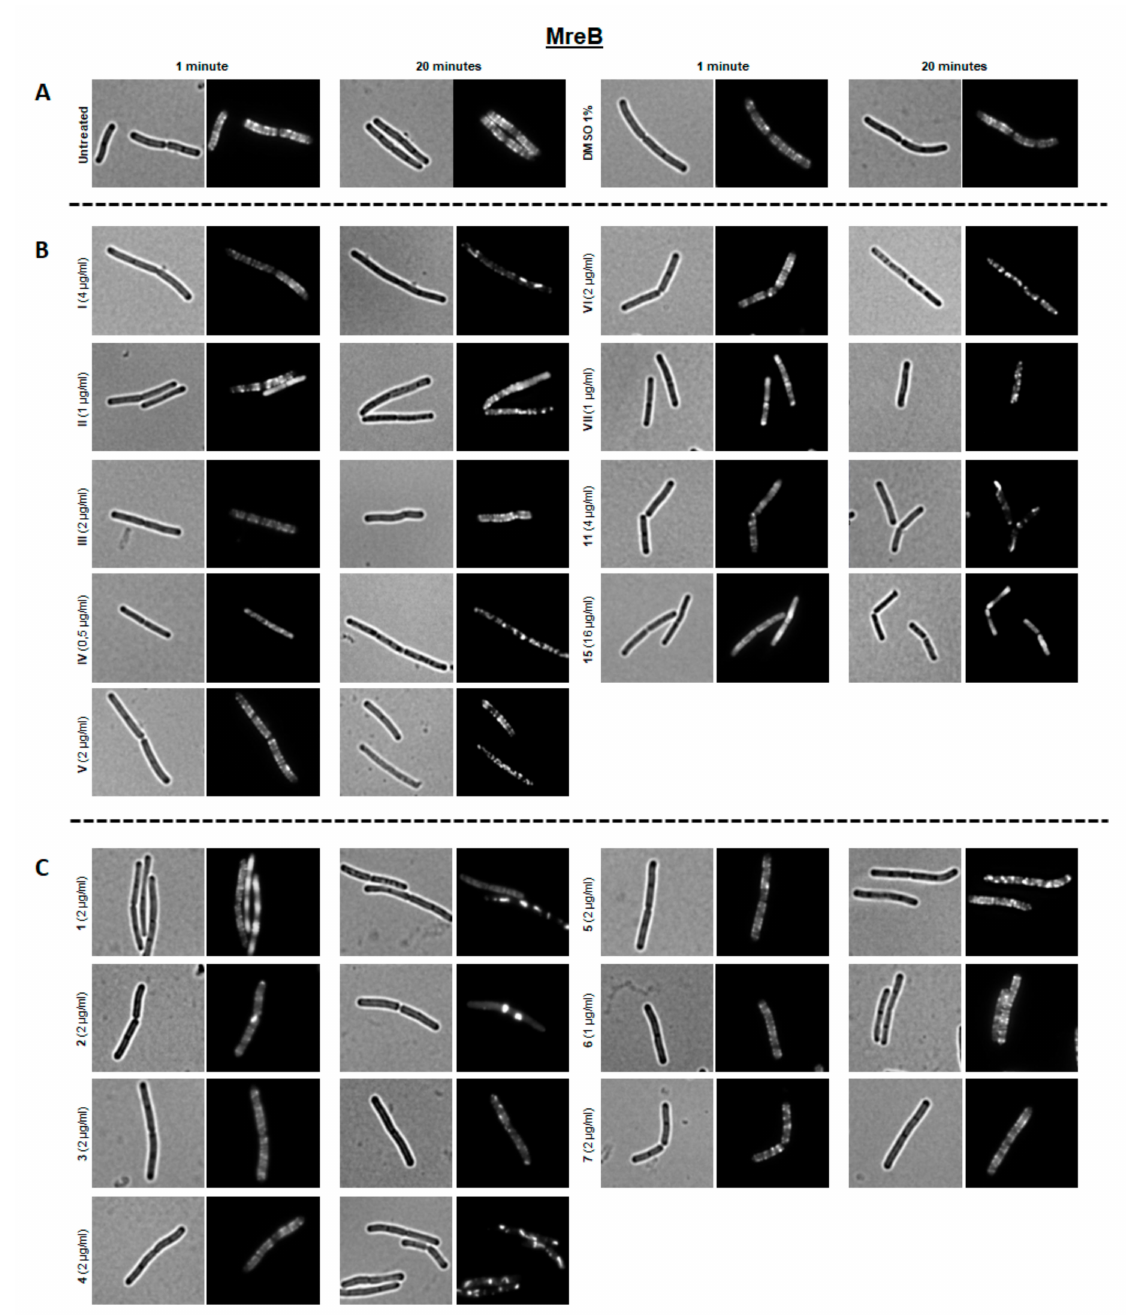
Figure 9. Representative microscopy images of MreB protein delocalization: ( A ) with untreated bacteria and with addition of DMSO 1% to control the proper growth of bacteria, ( B ) in the presence of cationic dendritic systems, ( C ) and in the presence of Ag(I)-NHC dendritic